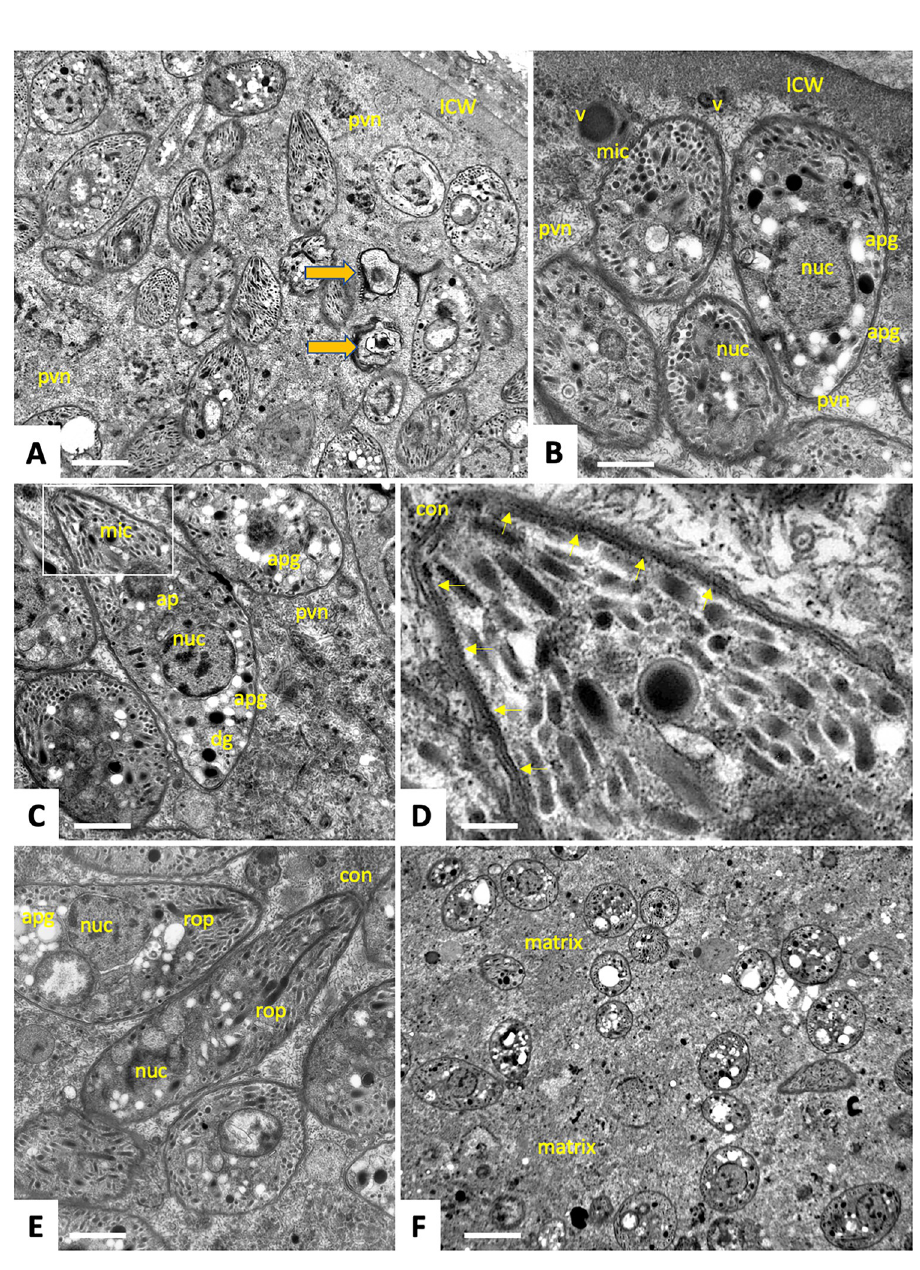
Fig 3. Transmission electron microscopy of the cyst interior and bradyzoites. (A) Bradyzoites embedded in the tissue cyst matrix in the peripheral area of the cyst. Non-viable bradyzoites are marked with yellow arrows. (B-E) Higher magnification view of bradyzoites with typical zoite organelles. (D) enlarged inset from (C) showing details of the conoid (con) and the inner membrane complex, IMC (arrows). (F) Bradyzoites in the centrally located area of the tissue cyst. apg: amylopectin granules, con: conoid, dg: dense granules, ICW: inner cyst wall, mic: micronemes, nuc: nuclei, pvn: parasitophorous vacuole network, rop: rhoptries, v: vesiculated structures. Bars in A = 1.2 μ m, B = 0.5 μ m, C and E = 0.6 μ m, D = 0.15 μ m, F = 1.4 μ